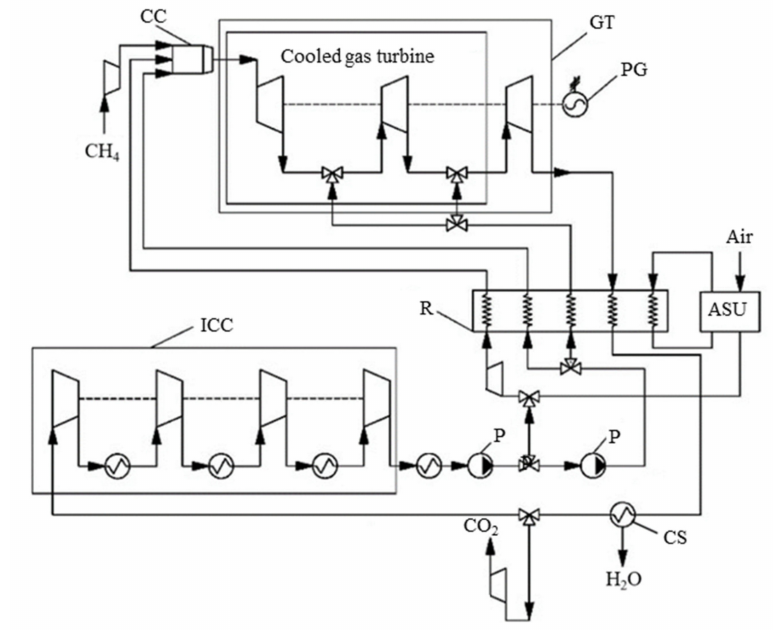
Figure 3. The Allam cycle flow